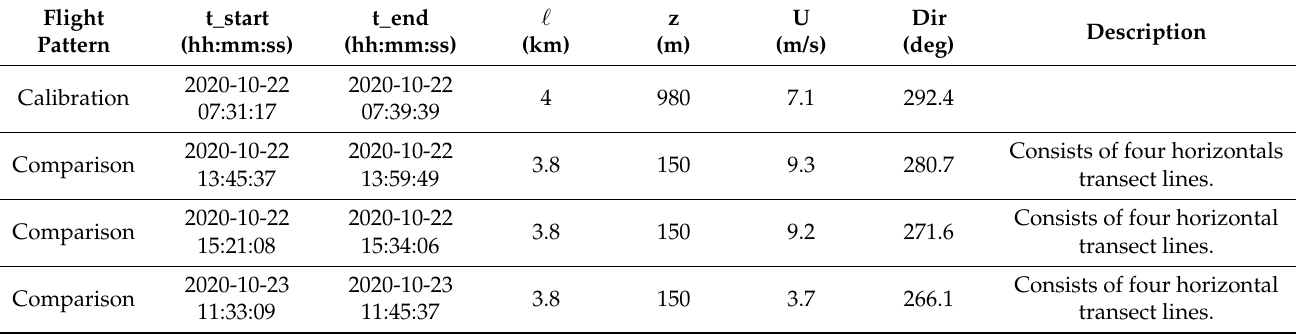
Table 3. Summary of the flight pattern and the meteorological condition during the in-flight test experiment: start time (t_start), end time (t_end), horizontal length ( (cid:96) , km), flight altitude (z, above ground level, a. g. l.), wind speed (U), and wind direction (Dir). Flight